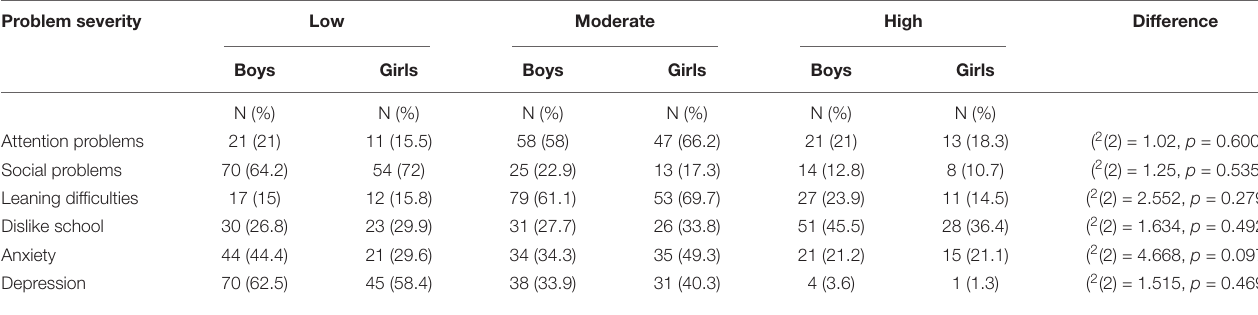
TABLE 1 | Children’s self-report of ADHD-related symptoms, by gender. Problem